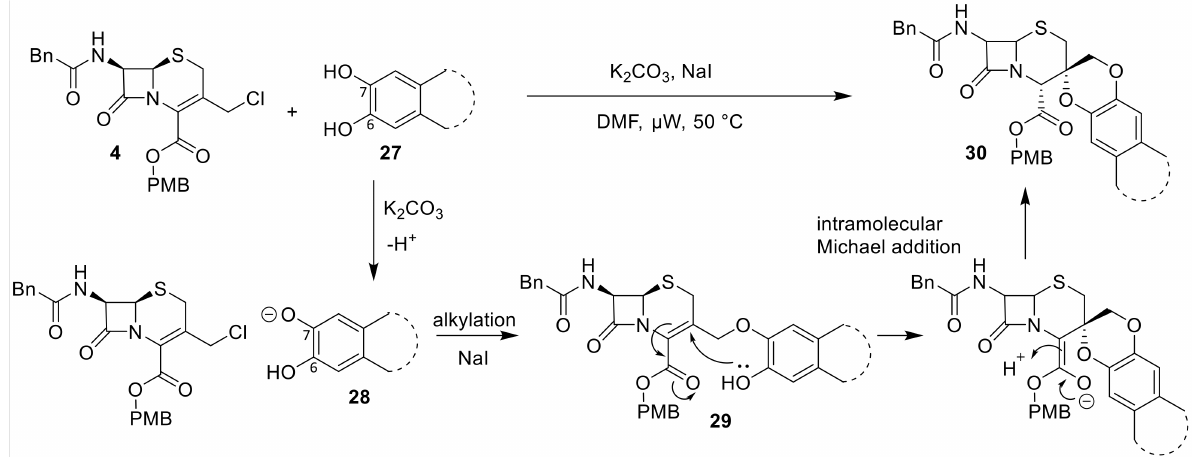
Figure 5. Proposed spiro-cyclisation mechanism for the formation of spiro-cephalosporin 30